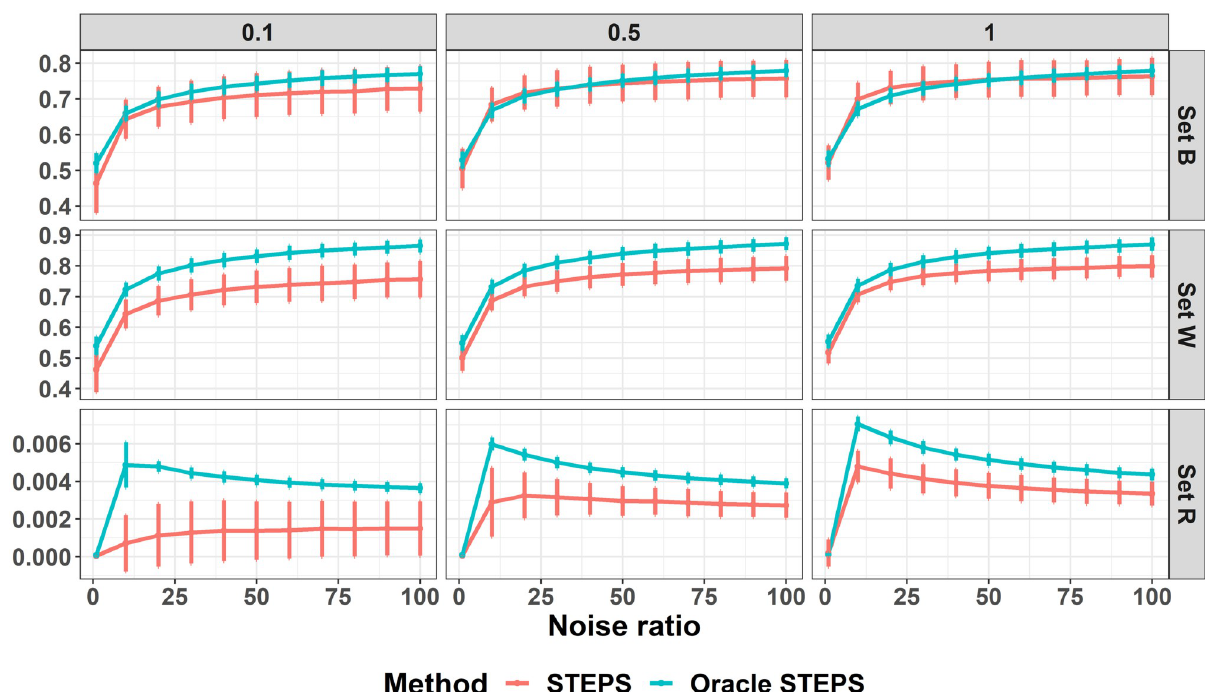
Fig 4. Concordance values gained in the simulation. Concordance levels for reconstruction of sets B and W , and average SD values for set R . X-axis presents noise ratio of that added to stress test features relative to the noise added to the observed clinical scores. Y-axis presents concordance for sets B & W and SD values for set R . Rows are for different sets and columns presents the different λ